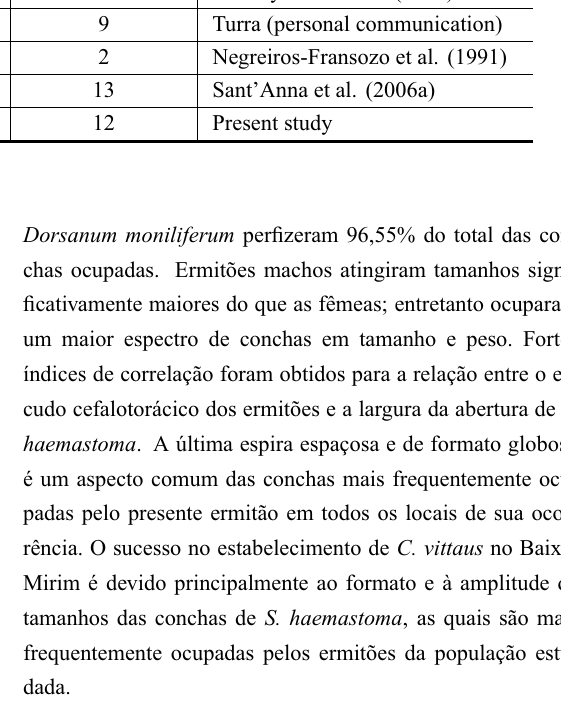
Clibanarius vittatus . Localities where the hermit crabs was reported, total number and most frequently occupied shell species. Most frequently occupied No. of Locality shell species by the occupied shell Reference hermit crab species